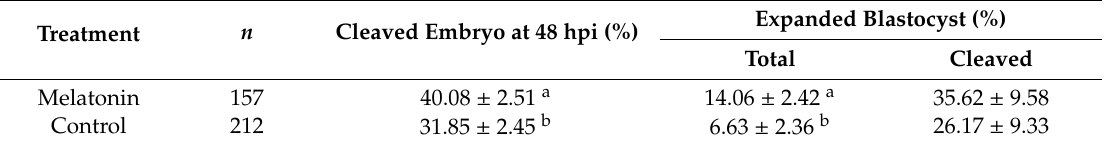
Table 2. E ff ect of melatonin supplementation during ovary transport on rates of cleavage and blastocyst development in Iberian red deer.